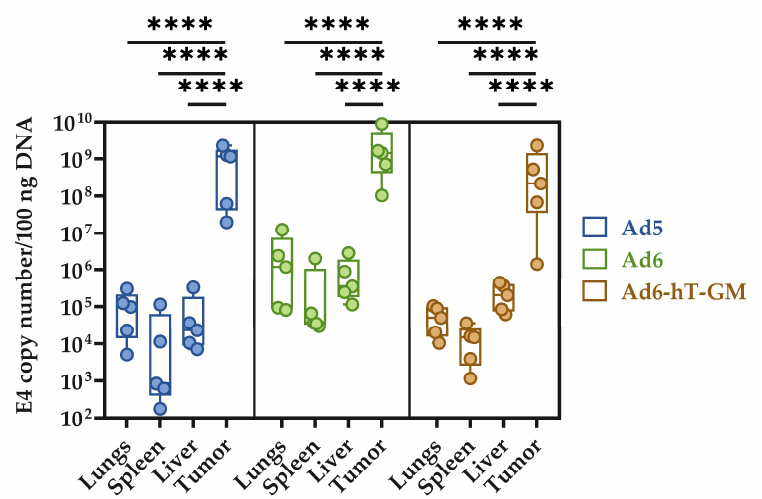
Figure 7. Adenoviral genomic DNA biodistribution in mice organs and tumors. E4 gene copy number per 100 ng of total DNA within the lung, spleen, liver, and tumor was evaluated using qPCR. The tumors demonstrated significantly higher DNA copy numbers compared to the organs (**** p < 0.0001). Data are presented as the Dot-boxplots, with n = 5 animals per group. The differences between cell viability levels were analyzed by ANOVA followed by Tukey’s HSD post-hoc test for pairwise comparisons.